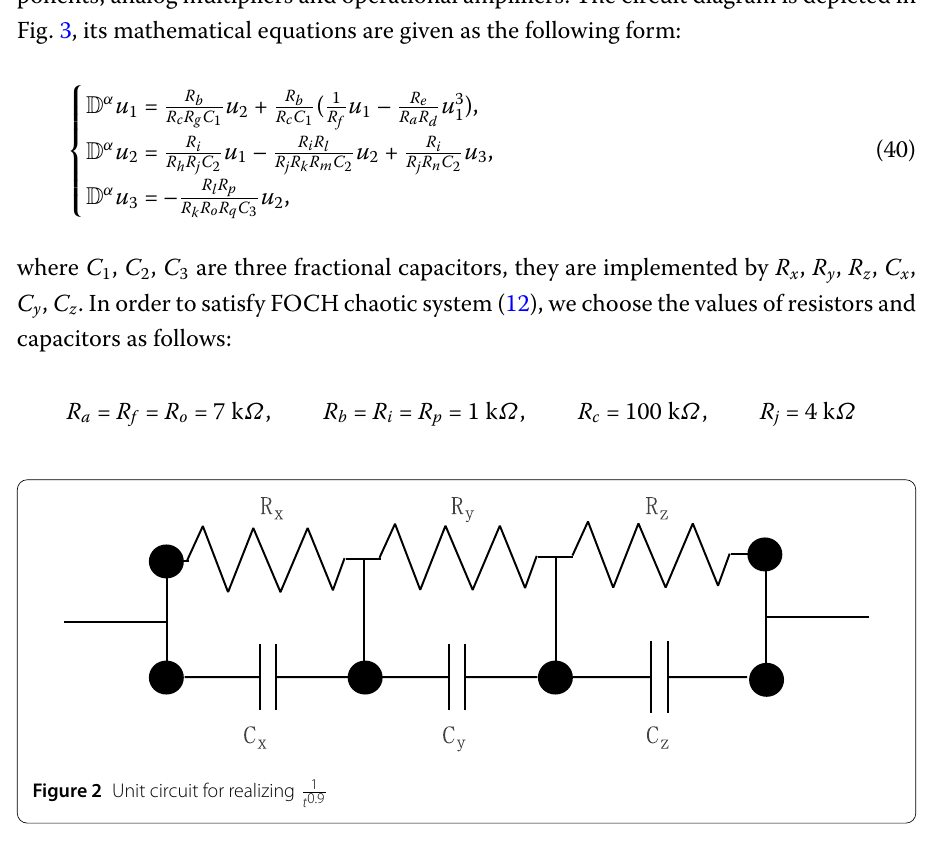
Figure 2 Unit circuit for realizing 1